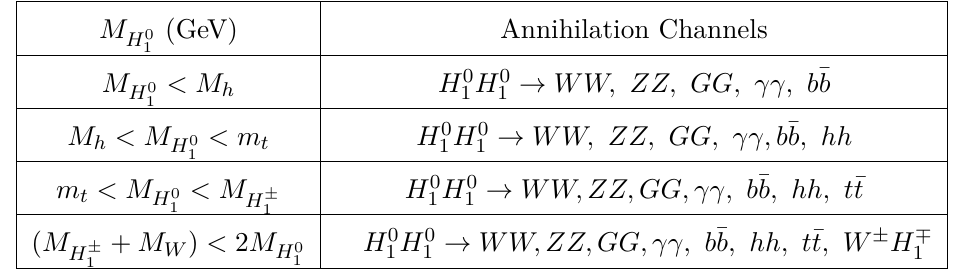
Table 2 . Annihilation channels for H 0